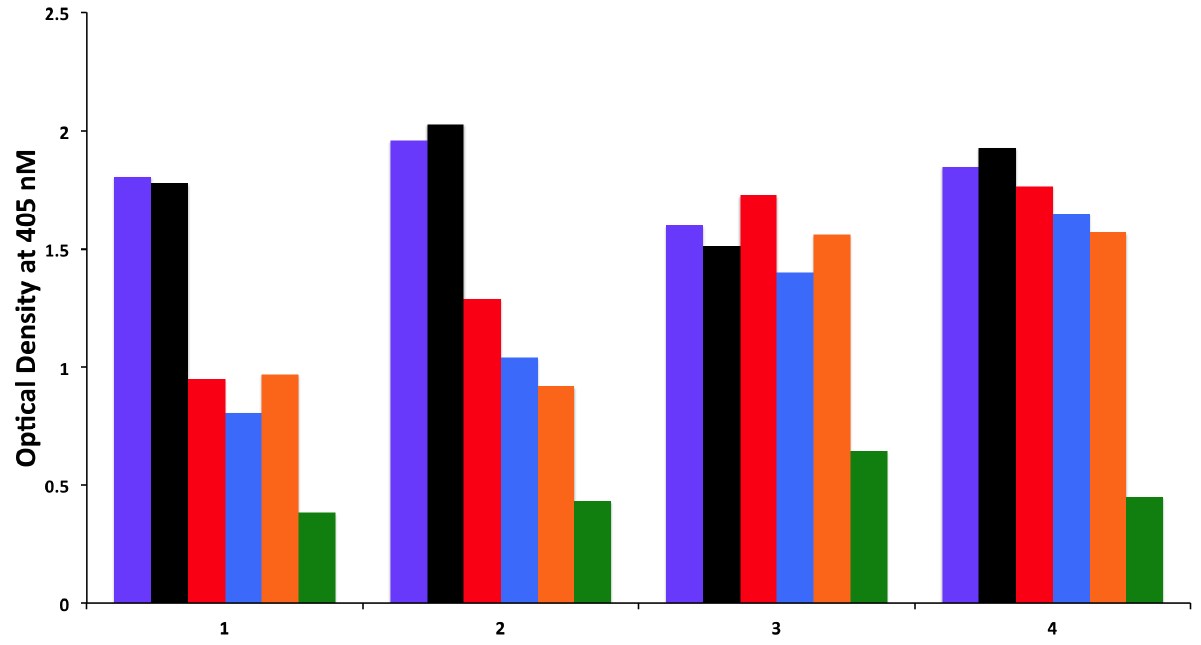
Figure 7. Inhibition of immune reaction of sera containing high levels of IgG, IgM and IgA antibody against MOG both before  and after absorption with HSA  , milk  , milk butyrophilin  , α + β -casein  , and MOG 